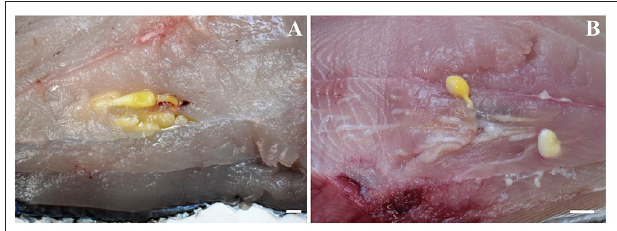
FIGURE 3 | Larvae of Molicola uncinatus (A) and Gymnorhynchus gigas (B) sequenced in the present study from the muscles of the Atlantic pomfret.